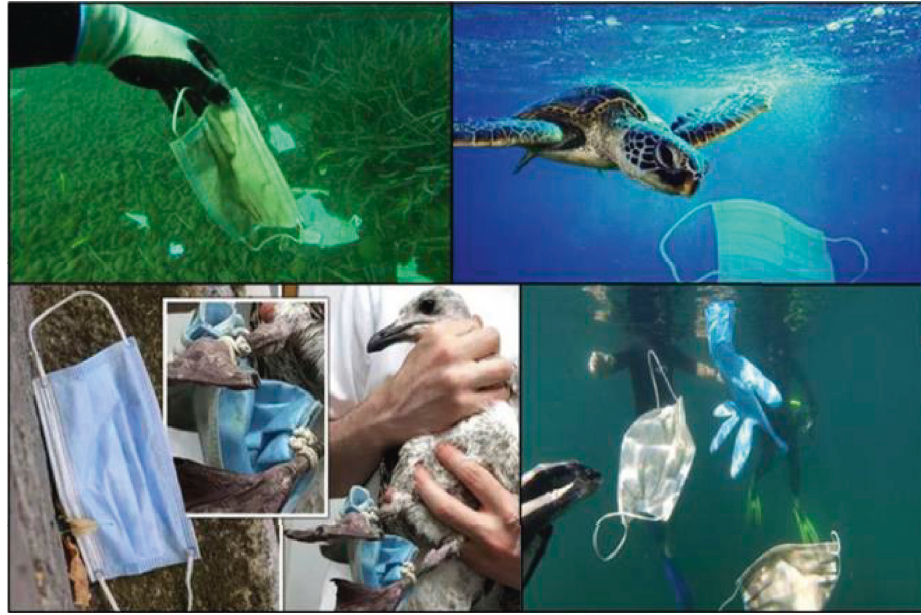
Figure 1: Different threats to life from the use of face masks (adapted with permission from Reference